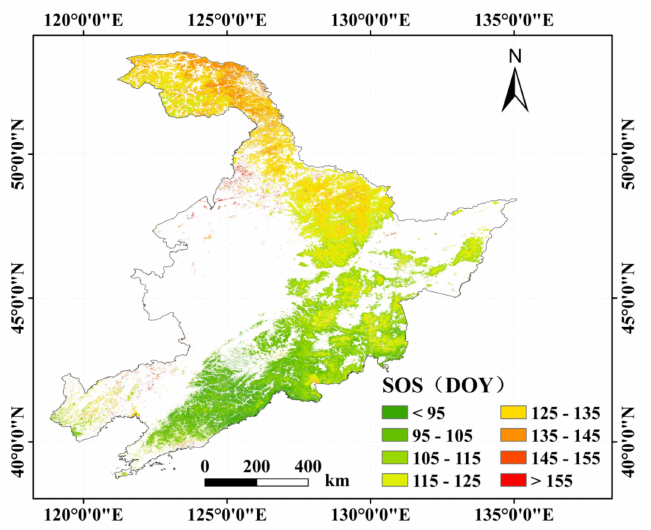
Figure 6. The spatial distribution of the average SOS (start of the growing season) from 2011 to 2020 in the northeastern